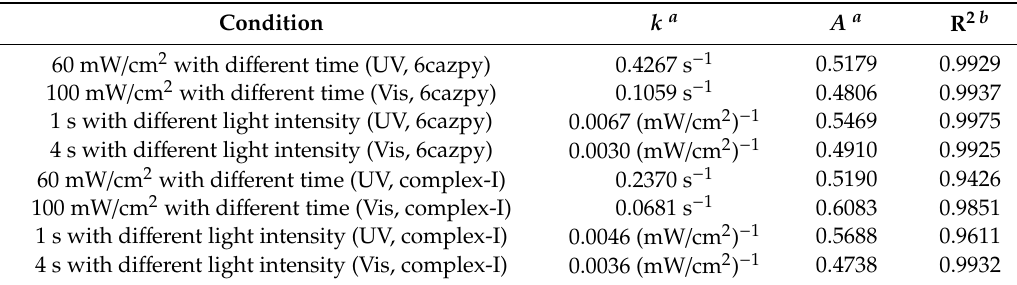
Table 1. The parameters of Equation (1) in di ff erent irradiation conditions when measuring the UV / Vis spectra.